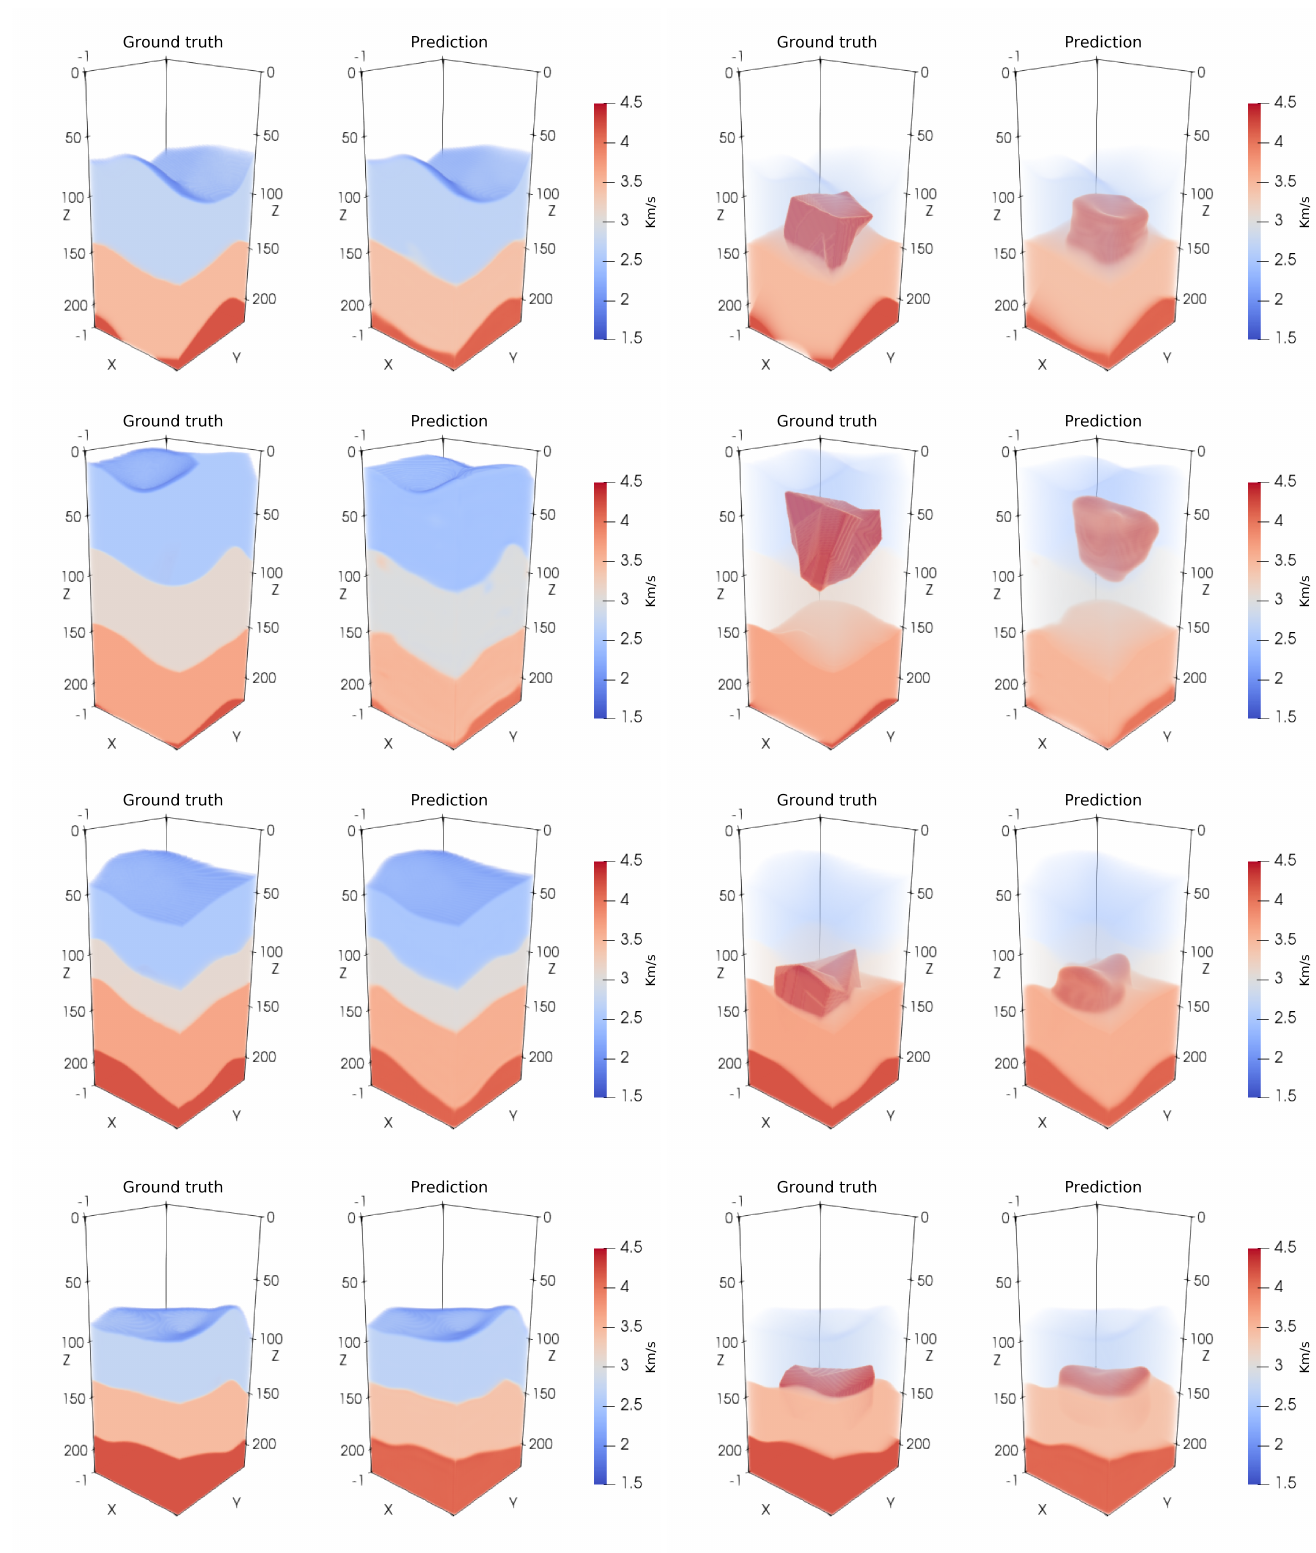
Figure 2. 3D inversion results of four velocity models with salt geometry, from the held-out testing set. Each row presents one model: the two left columns display the ground-truth and the corresponding inverted model. In the two right columns, the shallow layers (slow velocity) are removed to enable the visualization of the embedded salt